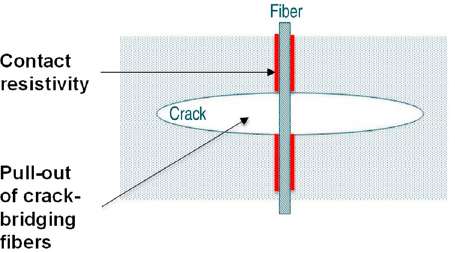
Figure 6. The cause of piezoresistivity in a cement-based matrix containing short carbon fibres [58,116]. Table 2. Causes of piezoresistivity in cement-based sensors. Cause